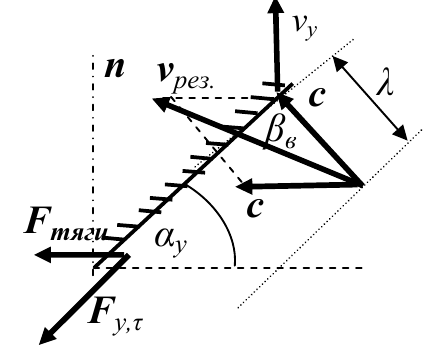
Рис . 3 – Схема взаимодей - ствия молекул воздуха с нижней поверхностью Figure 3 – Schematic presentation of the interaction of air molecules with the lower surface of the propeller front